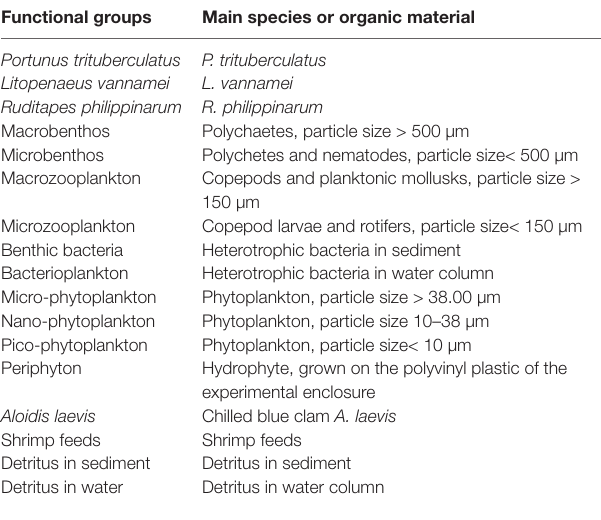
TABLE 1 | Functional groups and main species included in models of polyculture